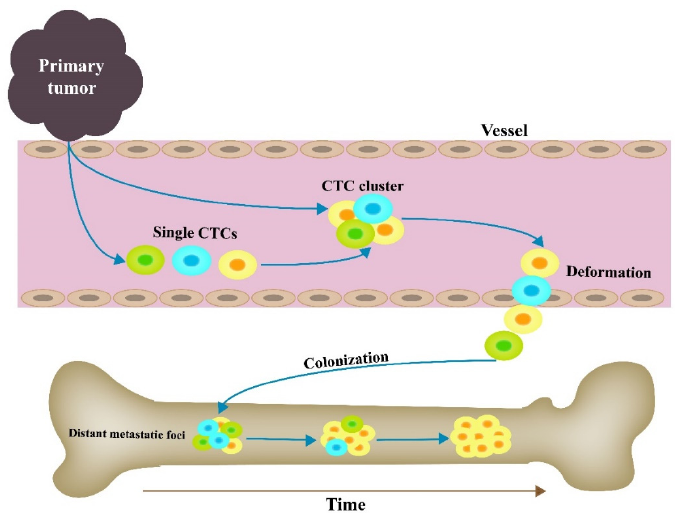
Figure 2. Illustrations of circulating tumor cell (CTC) cluster formation, extravasation, and colonization. CTC clusters originate from pieces of primary tumors or are assembled by single CTCs in peripheral blood. Then, CTC clusters reversibly unfold into single chains when they go through vessels, and they invade other parts of the body. Metastatic foci formed by CTC clusters are increasingly dominated by a single clonal population.